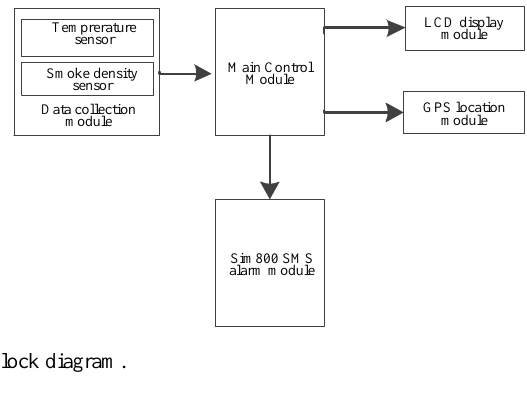
Fig. 1 . The system block